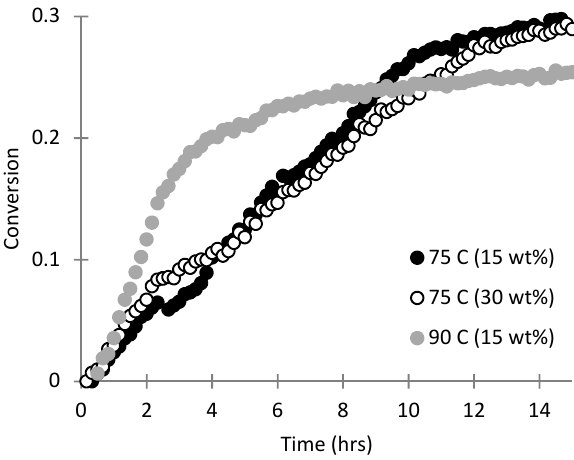
Figure 4. Monomer conversion profiles obtained by homopolymerization of SHMeMB at 15 and 30 wt % at 75 °C and 1 wt % V-86, and at 15 wt % and 90 °C.